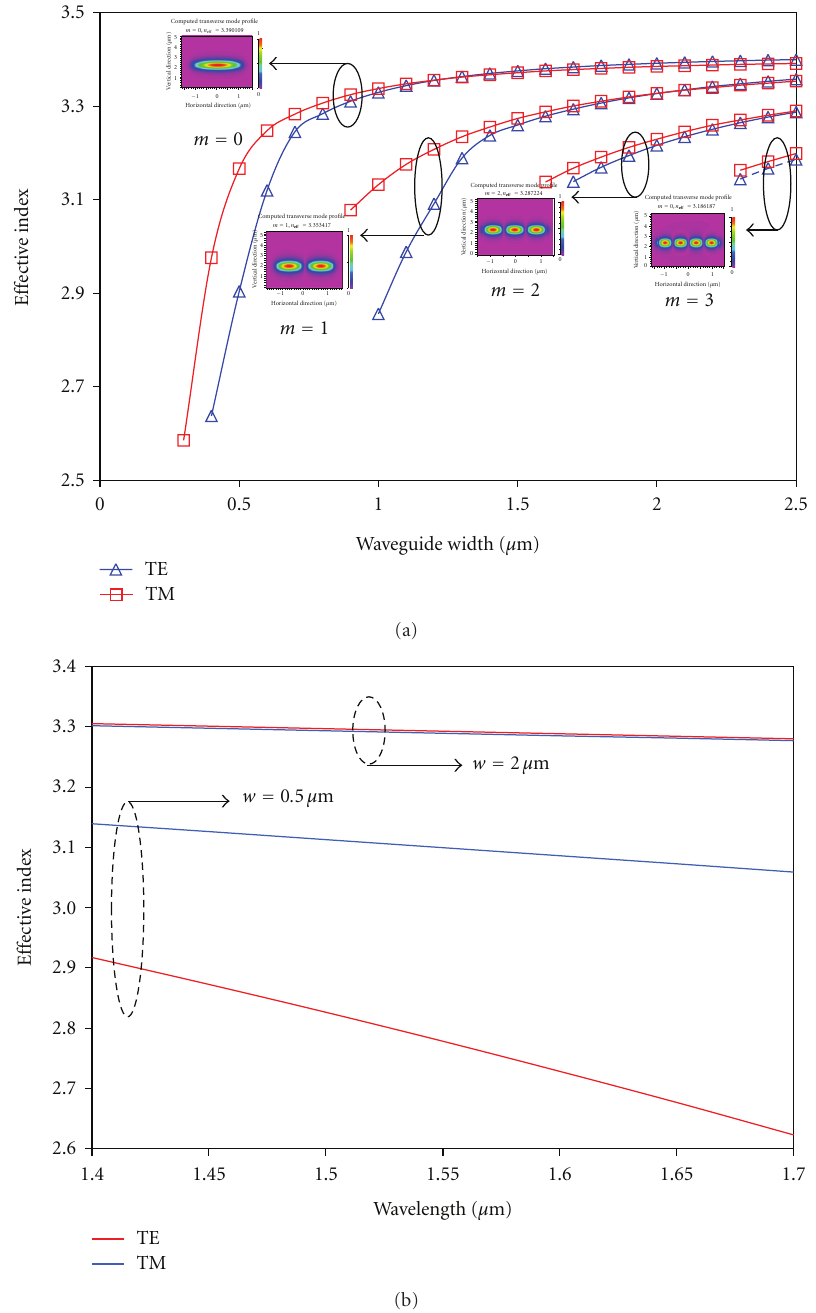
Figure 3: E ff ective indexes of InP/InGaAsP ridge waveguides for TE and TM polarizations as a function of (a) waveguide width and (b) operation wavelength. The InGaAsP core index is 3.5 while the InP cladding index is 3.17. All core thicknesses are 0.65 μ